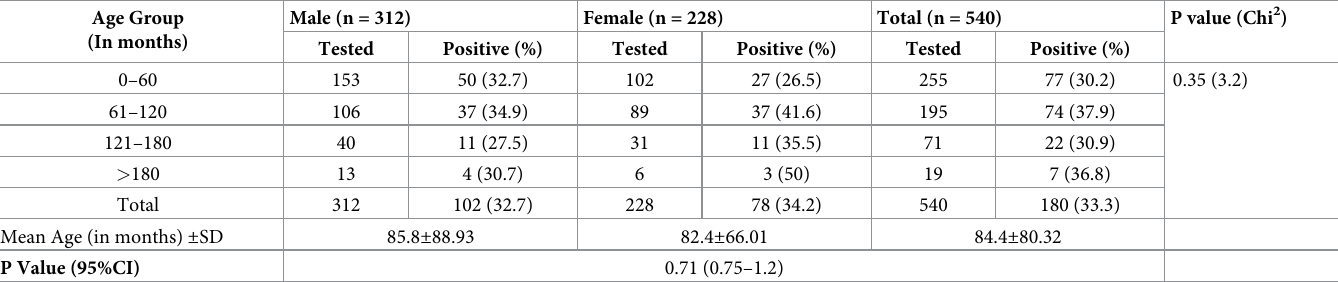
Table 2. Test positivity and age and sex distribution of total cases.